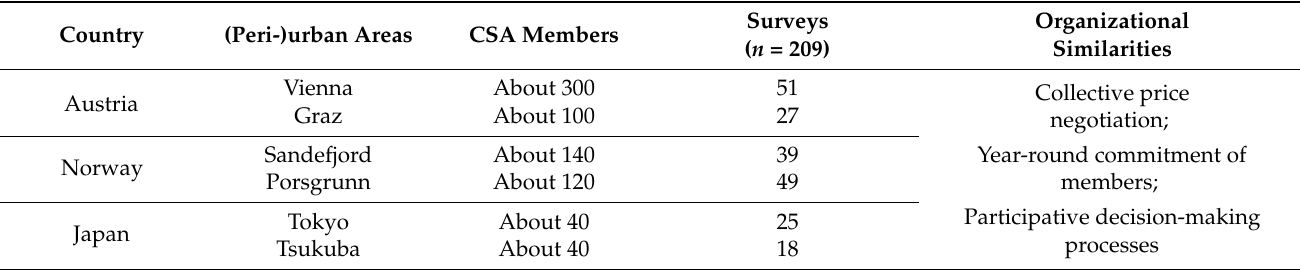
Table 1. Selected CSAs and number of respondents in Austria, Japan and Norway. Country